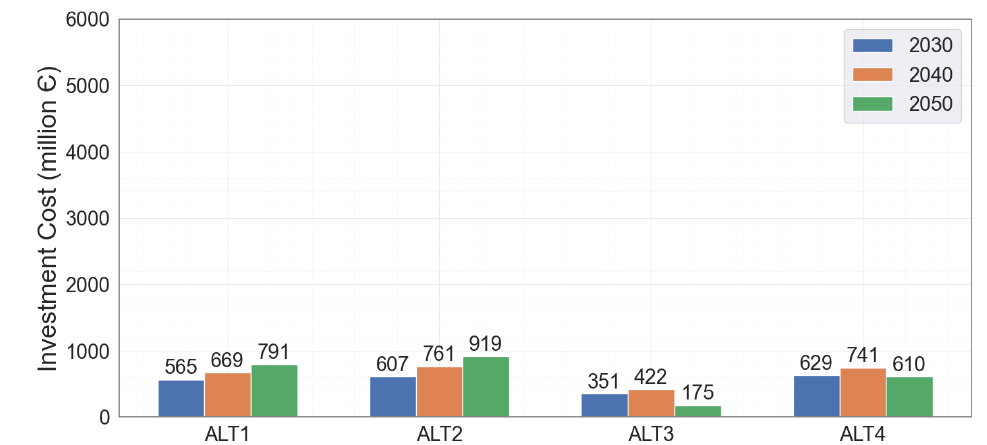
Figure 18. Comparison of the evolution of GHG emissions between alternatives for the service sector (%).